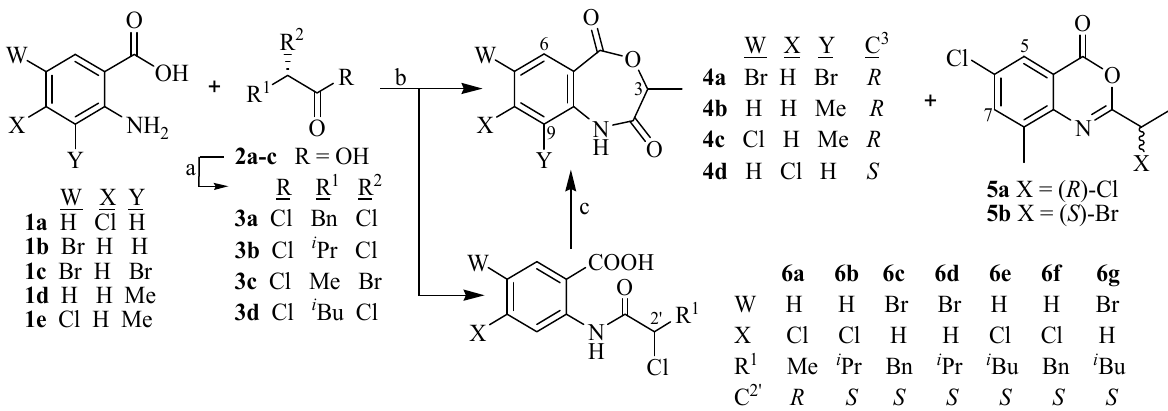
(1.5 eq), DMF (1 drop); ( b ) dropwise addition of 3 to 1 , DMF, 0 °C; 2